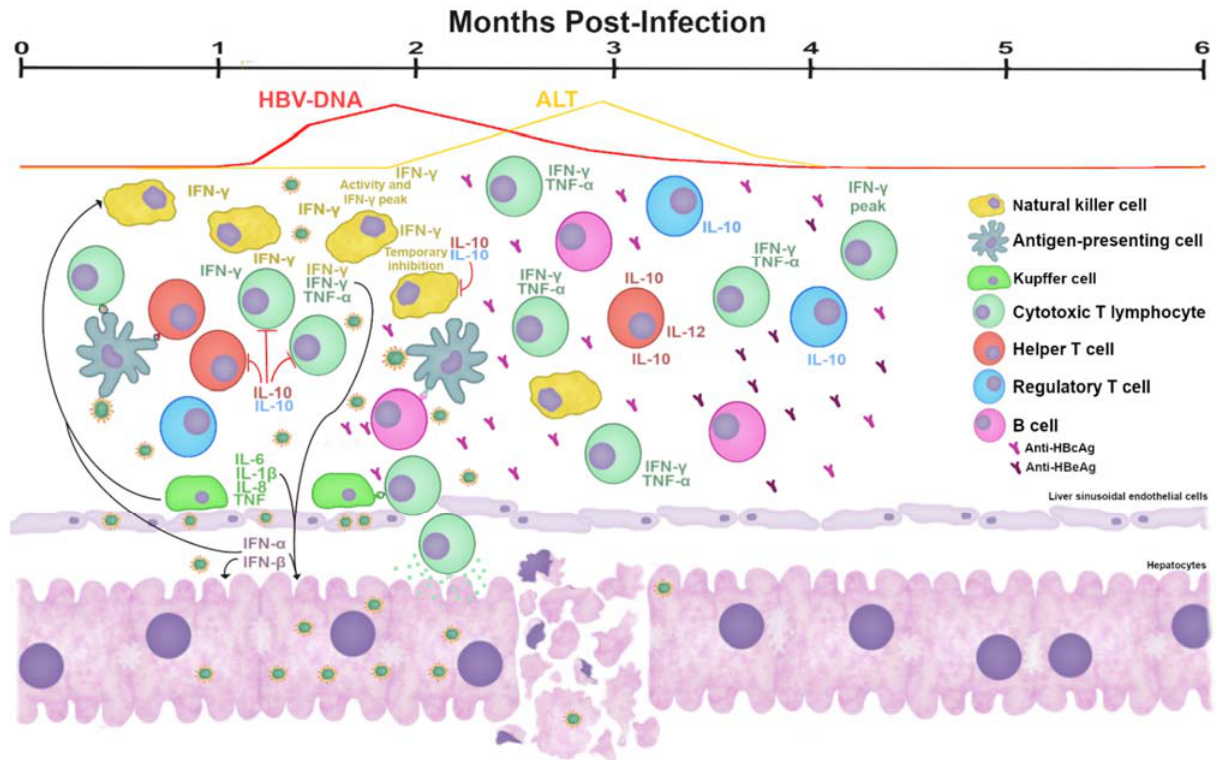
Figure 4. The potential dynamic of the immune response during AHB. Before the peak of HBV-DNA, the antiviral process is primarily mediated by non-cytolytic mechanisms, mainly by NK cells with IFN- γ and TNF- α production. During this stage, the functions of T cells may be slowed down by regulatory cytokines. Infected hepatocytes collaborate by producing IFN- α and IFN- β to fight the infection. KC cells could be participating by stimulating NK cells and by acting as antigen-presenting cells. After the peak of viral DNA in serum, the antiviral activity is performed mostly by T cells producing cytokines and antibodies (anti-HBc followed by anti-HBe). The cytolytic mechanism induced by HBV-specific CTLs leads to serum ALT increase. Serum HBV-DNA and ALT graphic was modified [95]. Cells and their secreted cytokines are in the same color. Trunked red lines indicate inhibitory effects. Abbreviations: HBV, hepatitis B virus; HBV-DNA, HBV DNA in serum; ALT, alanine aminotransferase; NK, natural killer; KC, Kupffer cell; IFN, interferon; IL, interleukin; TNF, tumor necrosis factor; CTL, cytotoxic T lymphocyte.